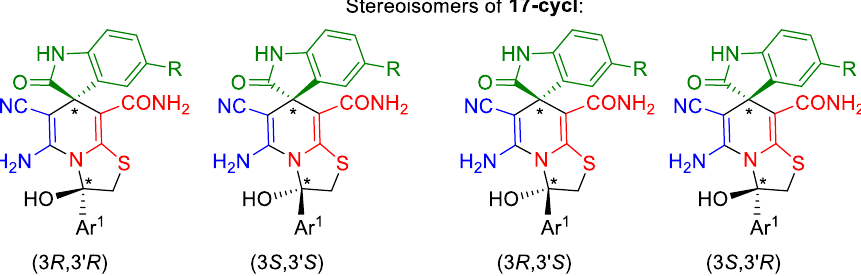
Scheme 8. Diastereomeric pairs of thiazolo[3,2-a]pyridine tautomers of compounds 17c,d-cycl . An asterisk (*) marks the chiral centers in the molecules.